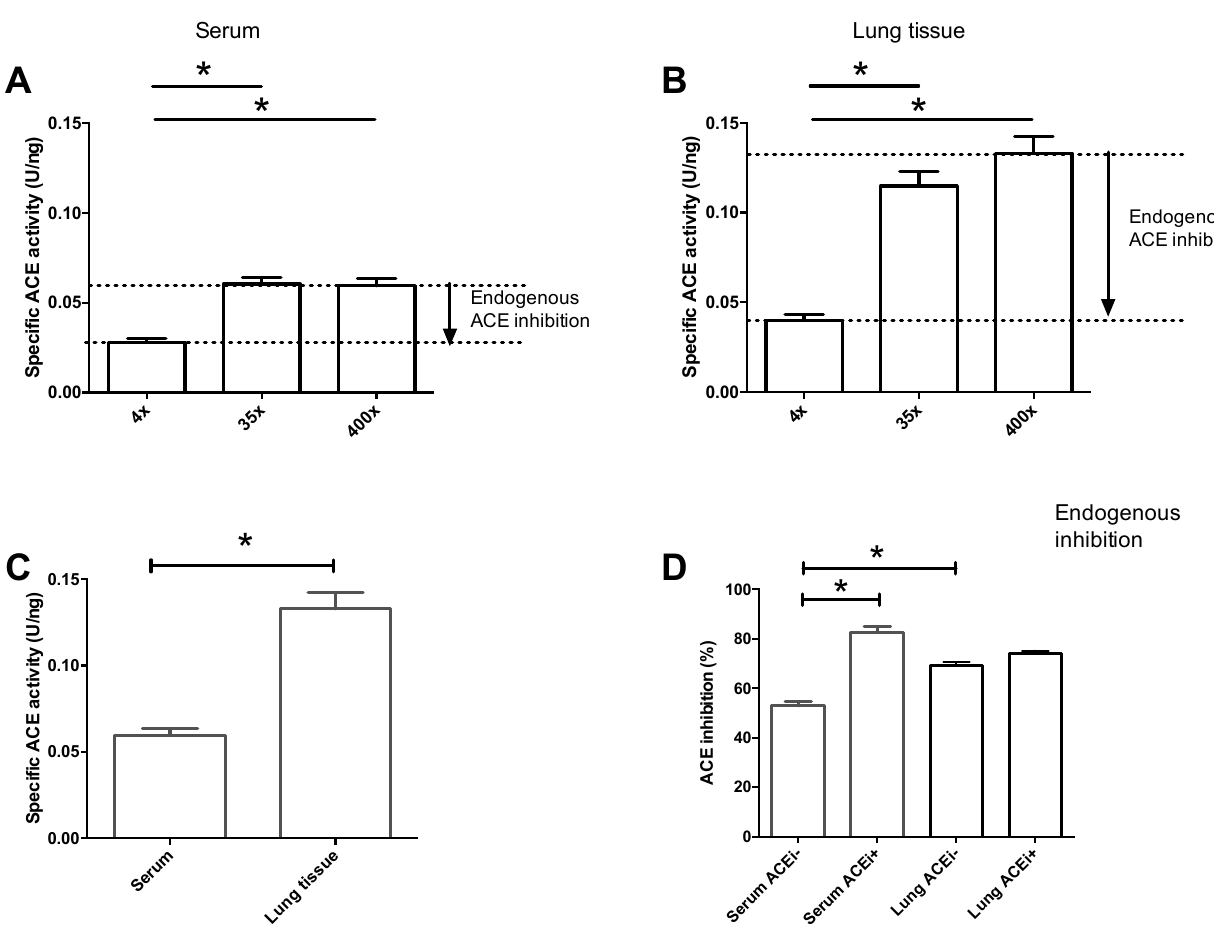
Figure 5. Both circulating and tissue ACE are endogenously inhibited. ACE activities were determined at various dilution levels (4-, 35- and 400-fold dilutions) in sera ( A ) and lung ( B ) homogenates. Activities were normalized to the ACE concentration of the same sample to yield specific enzyme activities, which are plotted on the graphs. Lower specific activity values at lower dilutions suggested endogenous inhibition (indicated by the arrows in ( A , B )). Specific activities determined at 400-fold dilutions are shown in ( C ). Levels of inhibition in patients without (ACEi − ) or with (ACEi+) ACE inhibitory medications (ACEi) are shown in ( D ). Bars represent the mean, while error bars show the S.E.M. of n = 42–47 determinations. Significant differences ( p < 0.05) are shown by the brackets and asterisks.